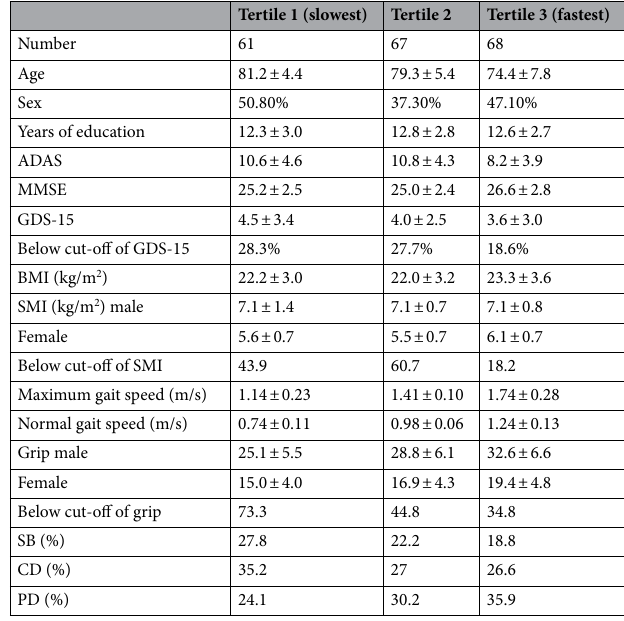
Table 3. Characteristics of participants in tertiles of normal gait speed. Mean ± Standard deviation was shown. Cut-off point for GDS-15 was 5/6. Cut-off point for handgrip strength of < 28 kg for men and < 18 kg for women; cut-off for low SMI was < 7.0 kg/m 2 in men and < 5.7 kg/m 2 in women. ADAS Alzheimer’s disease